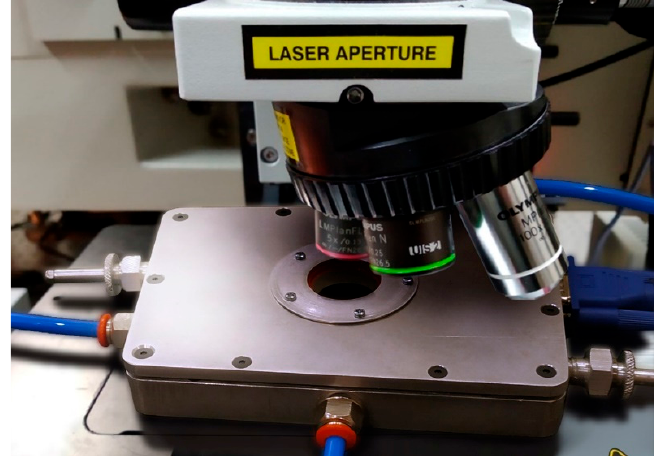
Figure 5. General view of the device for multipurpose research on dendritic Yanson point contacts and quantum sensing. The device is placed below the microscope of a Renishaw spectrometer.